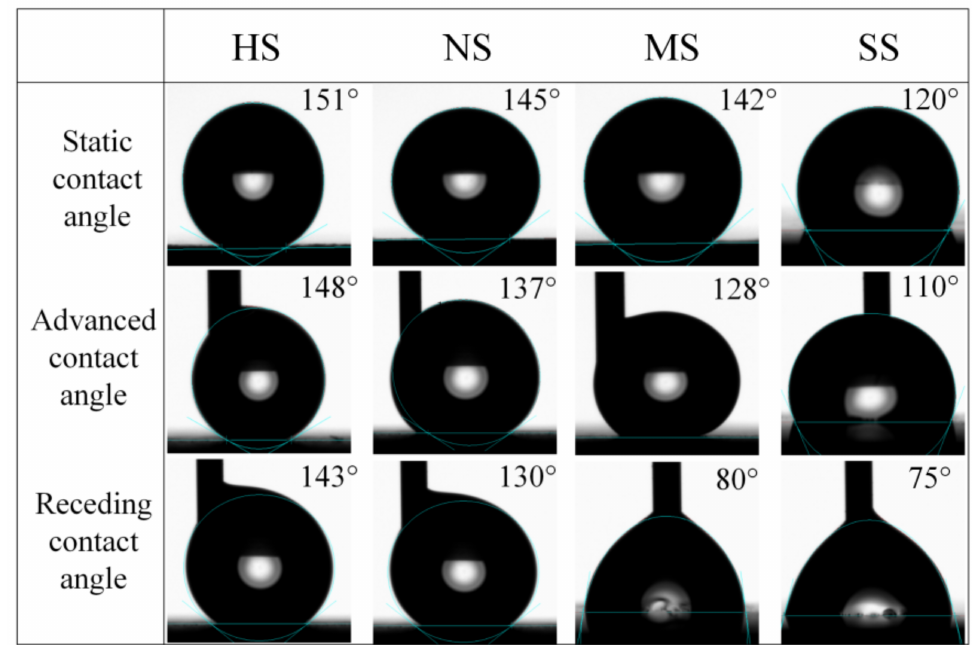
Figure 8. Measurement results of contact angle of four samples.